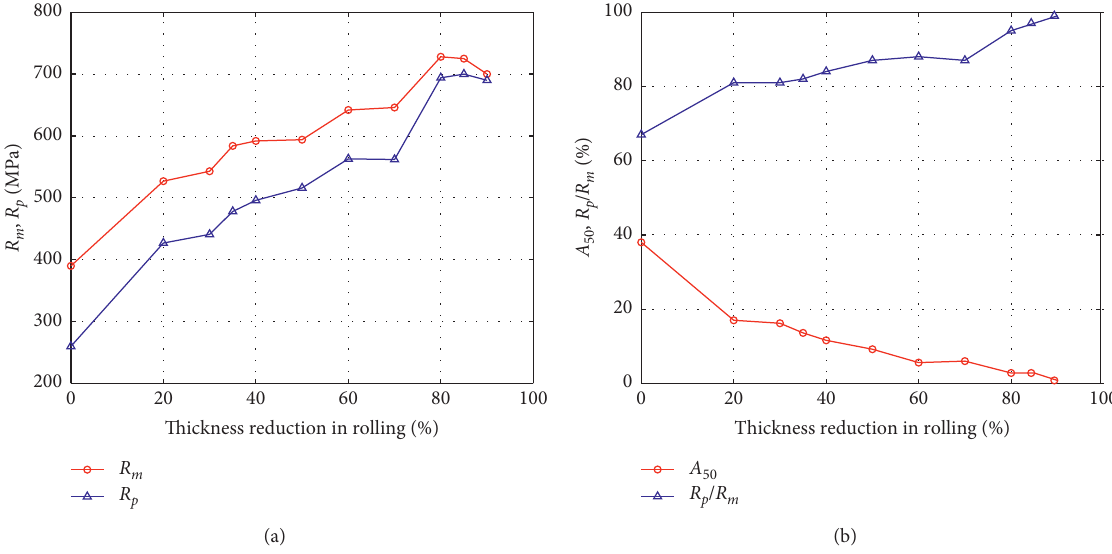
Figure 5: Effect of thickness reduction on mechanical properties.